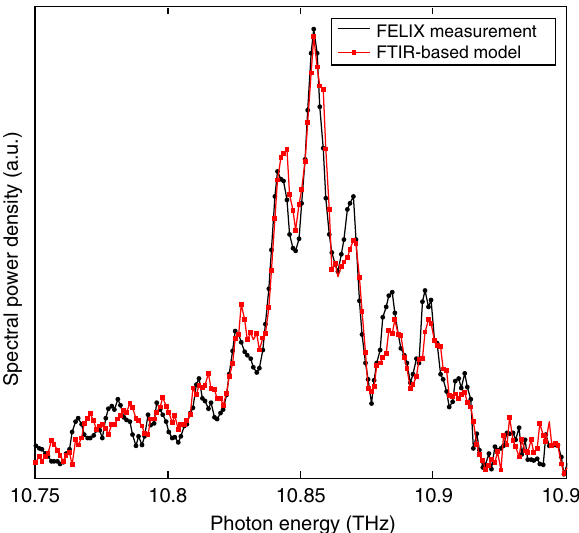
Figure 6 | Quantum beats in absorption. ( a ) Laser pulse autocorrelation interferogram from detector at (1) in Fig. 4e, showing the overlap of the laser pulses. ( b , c ) Absorption (PTIS) interferogram for different applied magnetic fields (noted in the figure). ( d – f ) FTs of the interferograms shown in ( a – c ). The grey envelopes in the frequency domain are fits with the FTof equation (3) convolved with a Gaussian lineshape (in the case of the laser autocorrelation we included a residual water vapour line at 9.45THz). The inverse FTs of these fits are shown in grey on the time-domain a – c . In the case of ( d ) (the autocorrelation), the laser lineshape is shown shaded light grey; a darker shade is used to show the effect of subtracting the fitted water